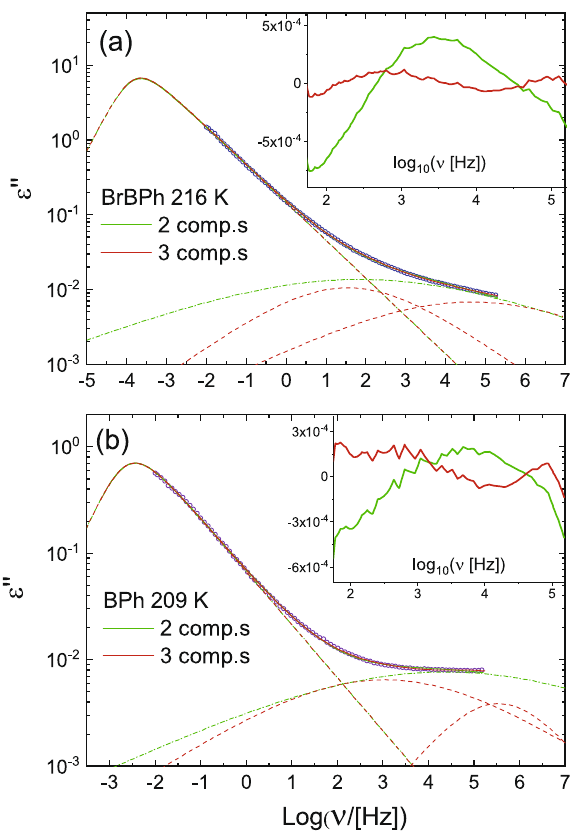
Figure 3. Comparison between the two-component and three-component fits of the ambient-pressure loss spectrum of BrBPh at T = 216 K ( a ) and of BPh at T = 209 K ( b ). Markers are data points, continuous lines are fits, and dashed lines represent fit components. The relative difference between either fit and the experimental spectrum are displayed in the inset to each